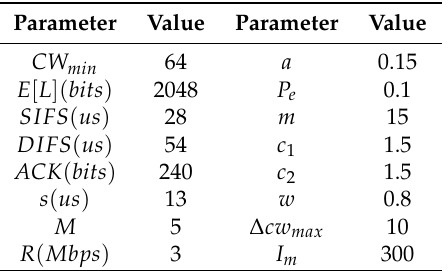
Table 1. Parameters used in the simulation